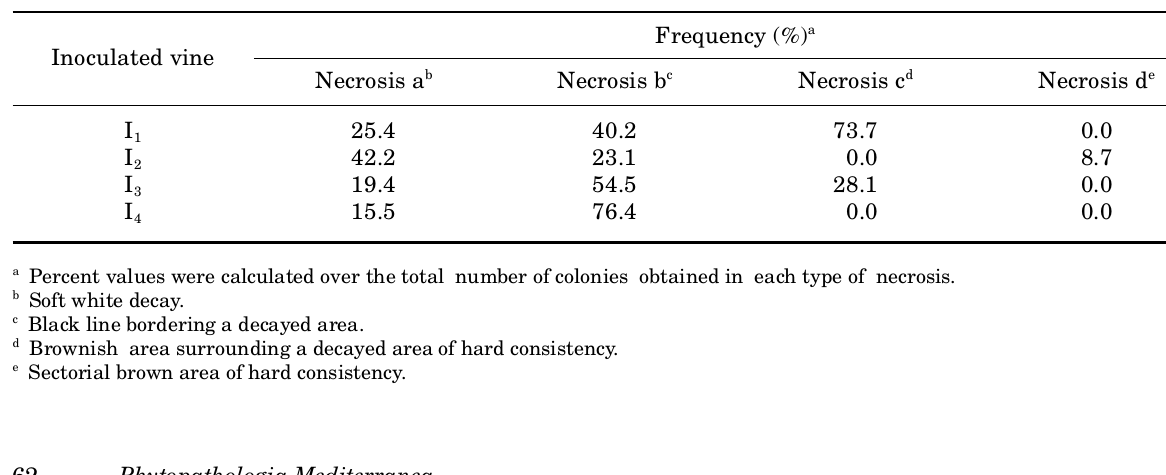
, I , I , I ) inoculated with Phellinus sp. (strain Fl 1 2 3 4